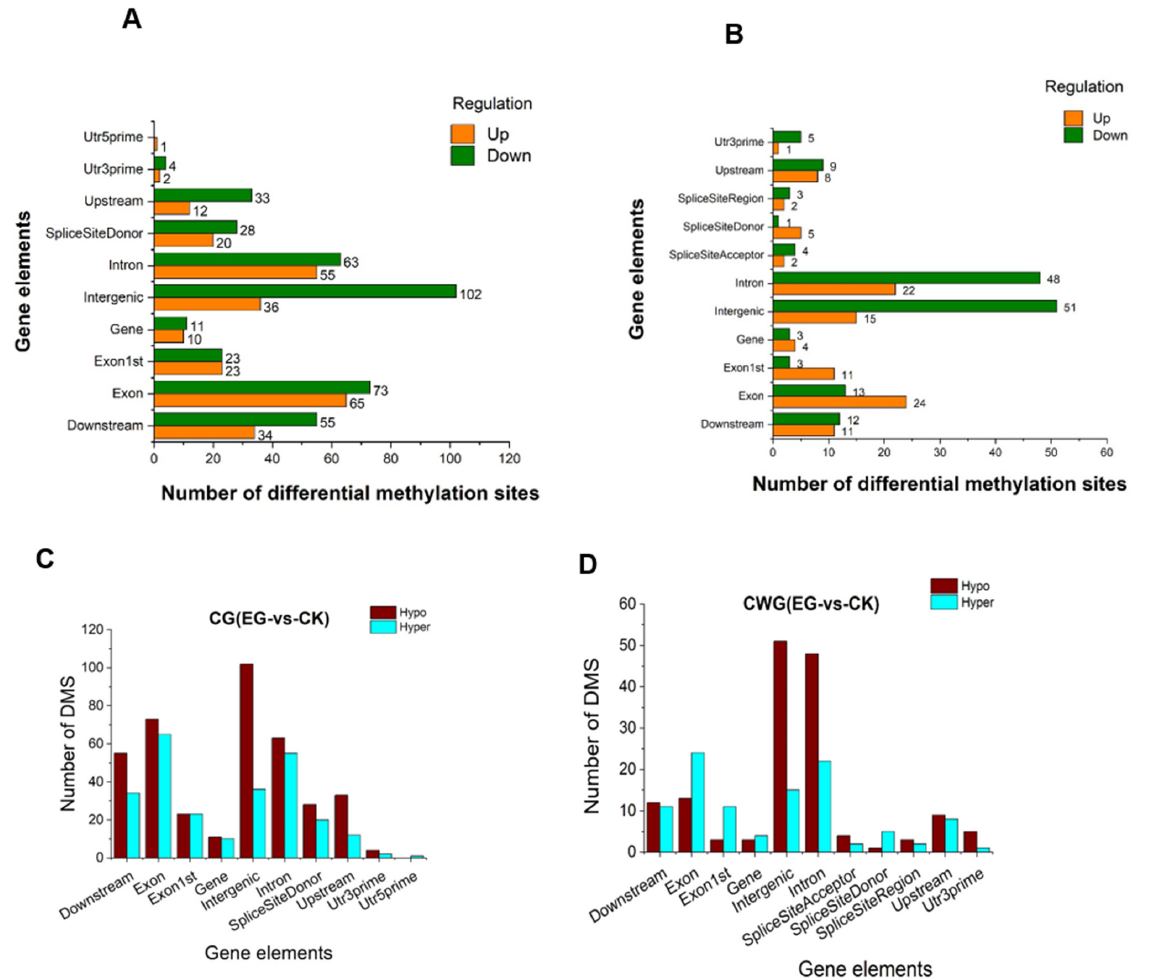
Figure 8. Distribution of differential methylation sites in different gene functional components. ( A ) CG bit with up and downregulation; ( B ) CWG bit with up and downregulation; the horizontal axis denotes the number of DMS; the vertical axis is the gene elements; ( C , D ) the differential hyper/hypomethylated site distribution in CG and CWG, respectively.